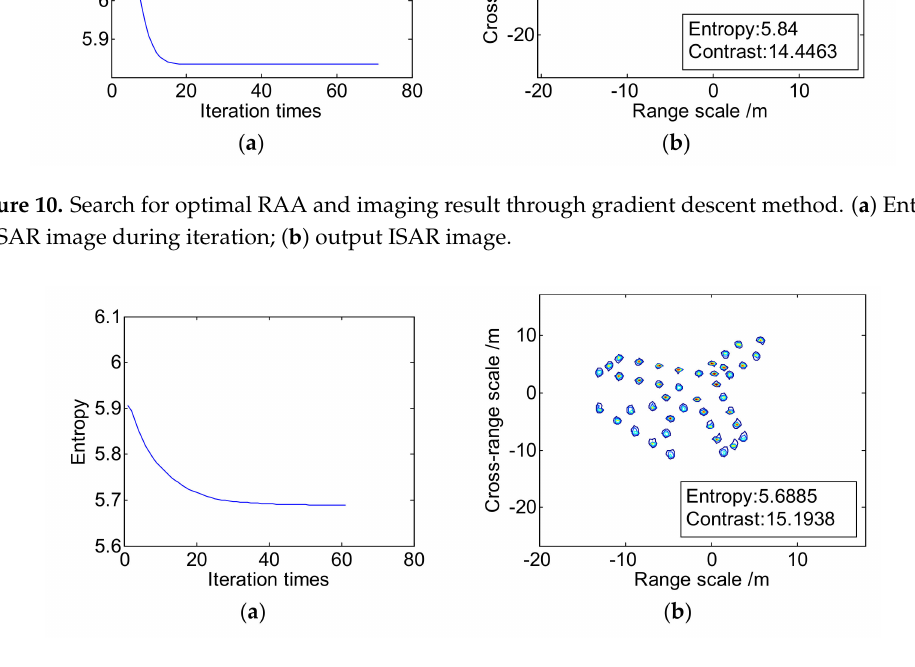
Figure 11. Search for optimal imaging result through two-dimensional gradient descent process. ( a ) Entropy of ISAR image during iteration; ( b ) output ISAR